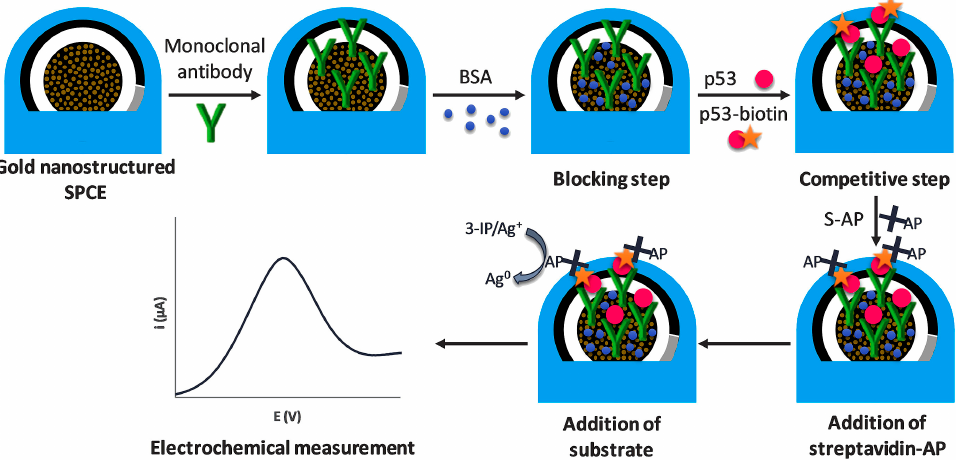
Figure 3. Scheme of the immunosensing strategy for the detection of unfolded p53 [14]. Copyright (2020) Elsevier.